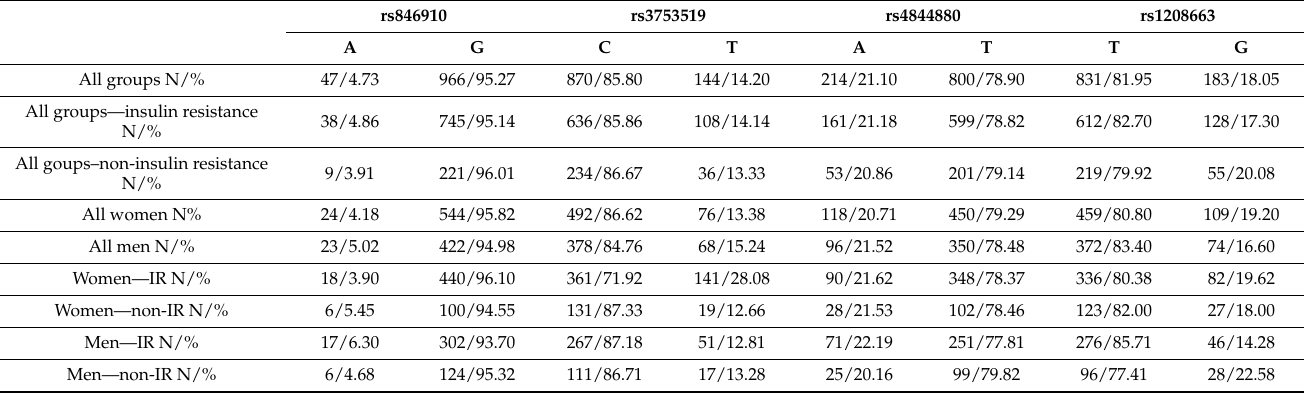
Table 3. The distribution of alleles tested rs12086634, rs846910, rs4844880, rs3753519 of the 11 β -hydroxysteroid dehydroge- nase type 1 ( HSD11B1 ) gene in the entire study group of subjects, in women with and without insulin resistance, and in men with and without insulin